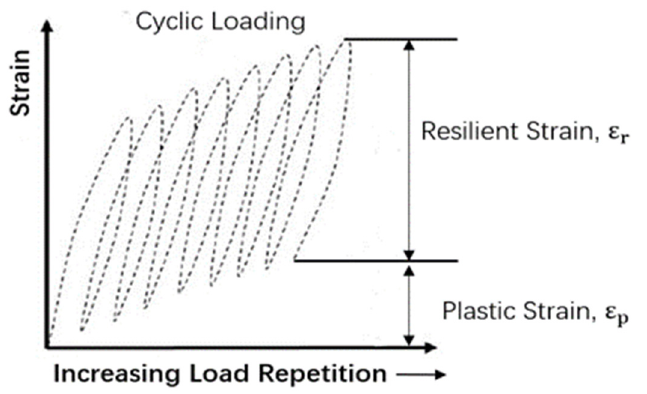
Figure 1. Characteristic stress–strain behavior [36].